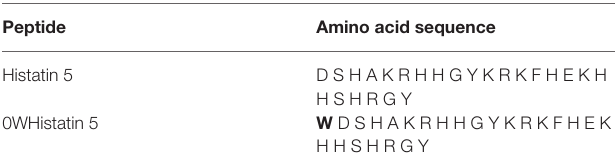
TABLE 1 | Amino acid sequence of Histatin 5 and the synthesized 0WHistatin 5 analog peptide. Peptide Amino acid sequence Histatin